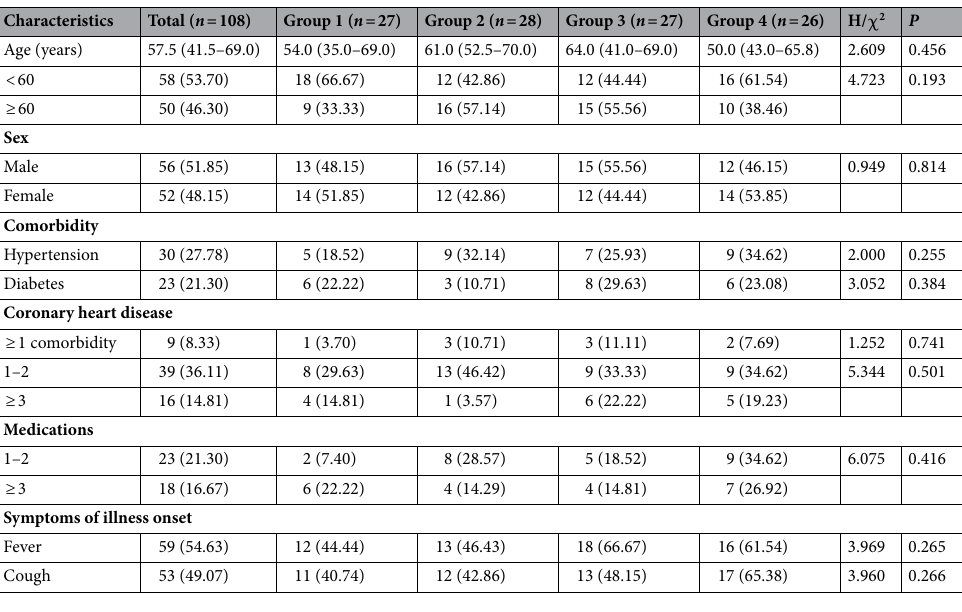
Table 1. Comparisons of baseline demographic and clinical characteristics across the four groups. Data are shown as median (interquartile range) or n (%). P values were calculated by Kruskal–Wallis test, χ 2 test or Fisher’s exact test, as